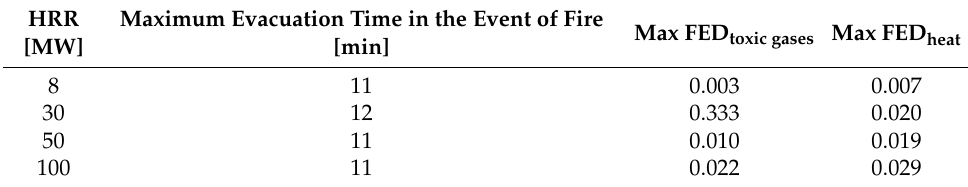
Table 5. FED results at a height of 2 m along the escape path when the fire is in the middle of tunnel length.